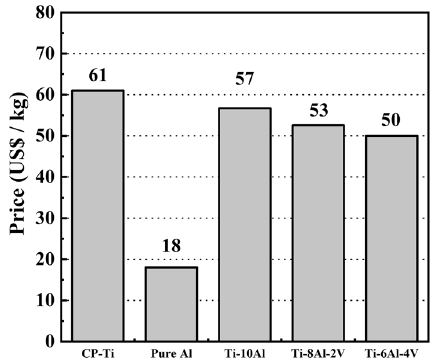
Figure 10. Estimated price to manufacture the